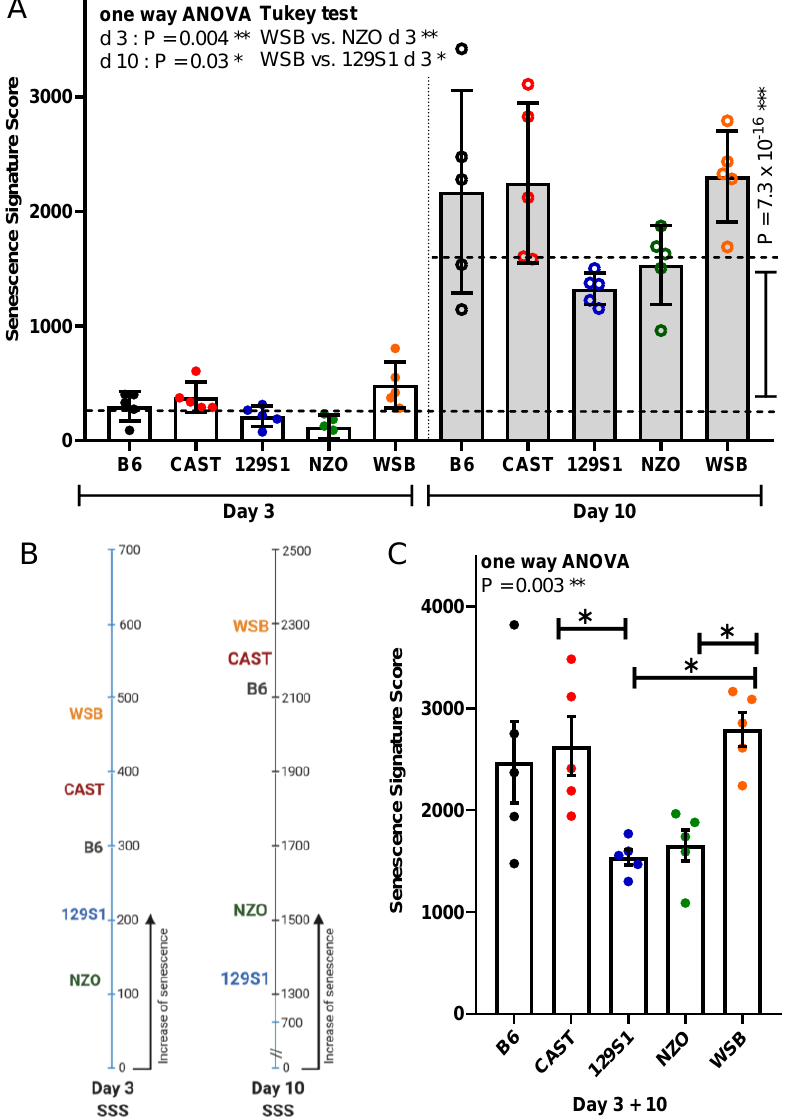
Figure 6. Senescence signature score combining all markers. ( A ) A senescence signature score composed of all five markers (SA-β-gal, γ-H2AX+/Ki67−, Cdkn2a, and Lmnb1 expression, SASP) was calculated for each mouse and categorized by strain to define the overall levels of SASP secretion for days 3 and 10 after irradiation. ( B ) Mean of senescence signature score (SSS) for each strain. ( C ) Combined sum of SSS for days 3 and 10. Results are presented as means ± SEM ( n = 5 mice for each strain). Significance between means of strains and means of time points were tested by the one-way ANOVA and t -test, respectively. Tukey’s test was performed as a post-hoc analysis in the case of multiple comparisons. Results from days 3 and 10 are tested separately. * p < 0.05; ** p < 0.01; *** p < 0.001.